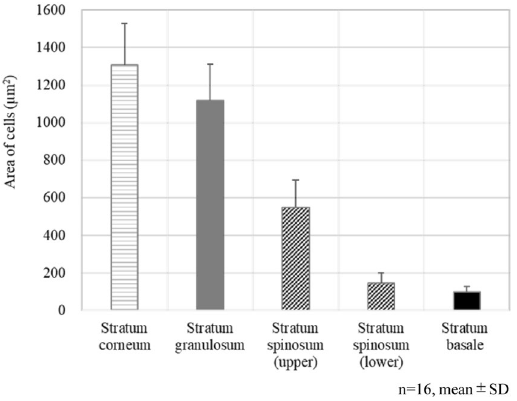
Figure 3. Changes in the size of keratinocytes during epidermal keratinocyte differentiation. Average area of each layer in 16